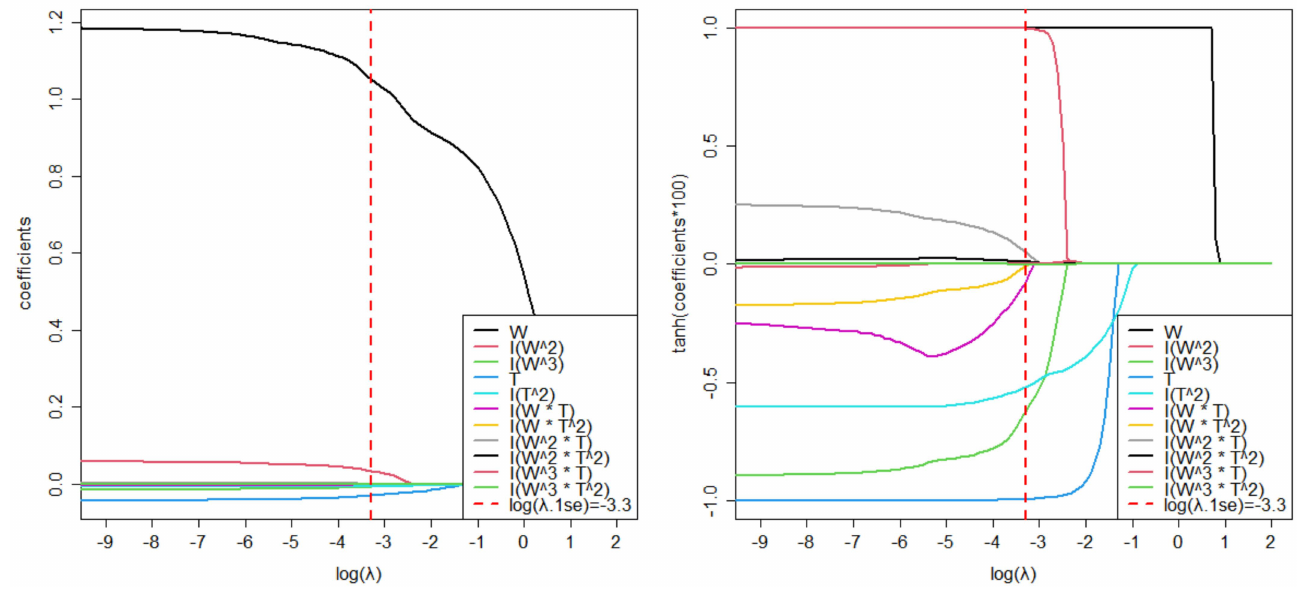
Figure 8. Relationship between the regularization parameter λ and the coefficients in LASSO re- gression. The graph on the right transforms the scale of the left graph using the hyperbolic tangent function ( tanh ( 100 x ) ) for ease of